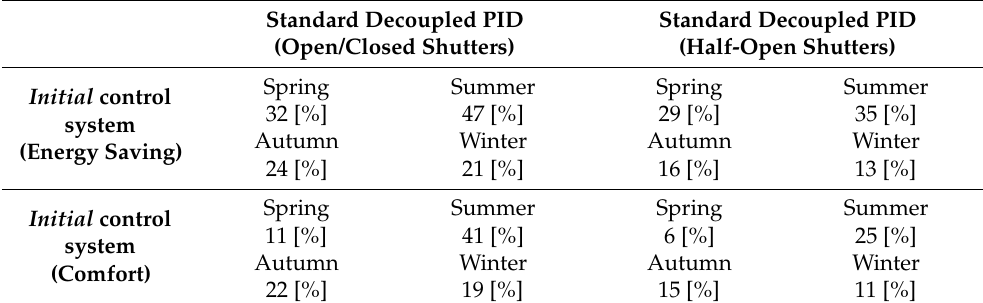
Table 13. Energy saving results: comparison between the initial control system and the standard decoupled PID